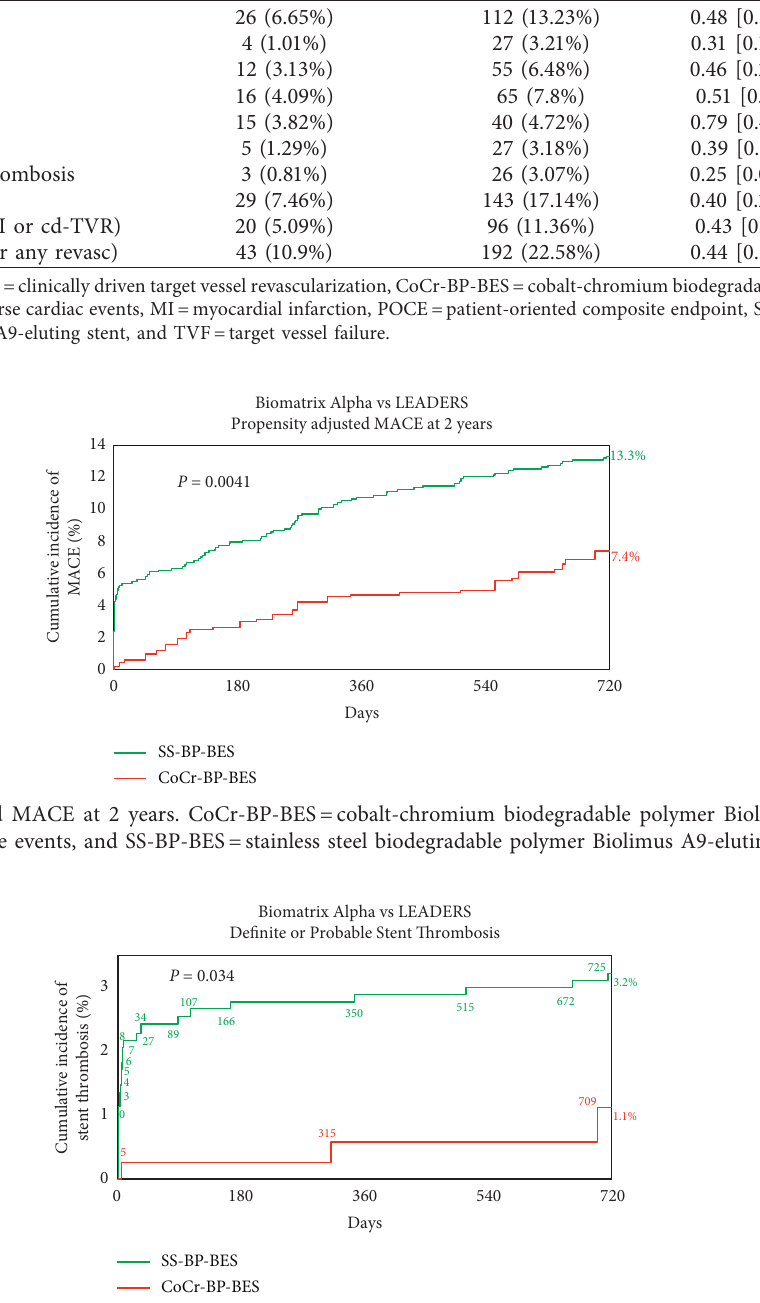
Figure 3: Propensity-adjusted definite or probable stent thrombosis at 2 years. Stent thrombosis was adjudicated using identical criteria